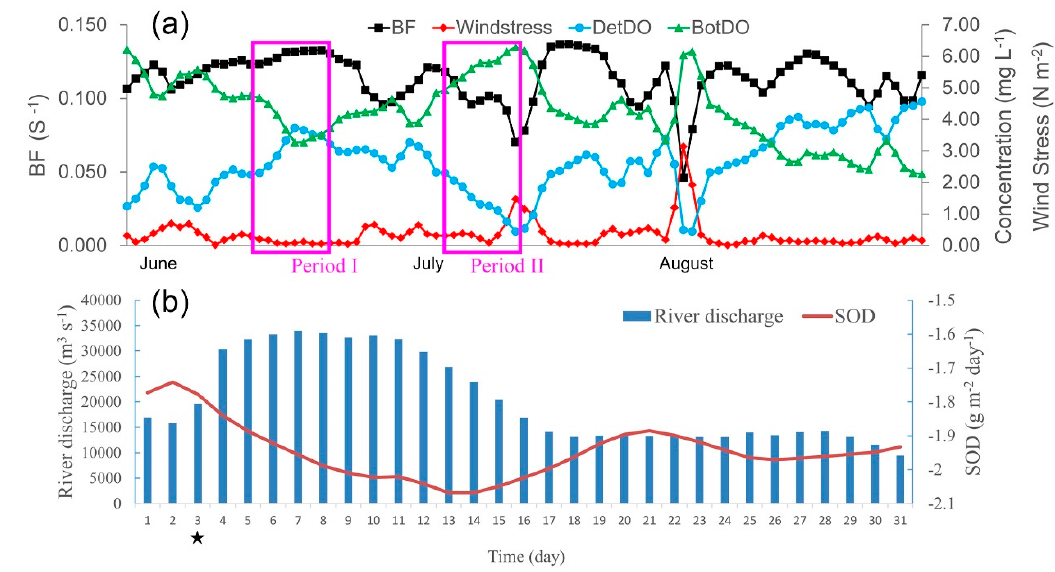
Figure 11. ( a ) Daily average value of the Brunt–Väisälä buoyancy frequency (BF, black line), wind stress (red line), DO concentration differences between the surface layer and bottom layer (DetDO, blue line), and the bottom DO concentration (BotDO, green line) in the Modaomen hypoxic zone of the base case from June to August. The pink windows denote the weak wind (Period I) and strong wind (Period II) periods, respectively. ( b ) Time series of the Pearl River discharge and the SOD in the Modaomen hypoxic zone during August 2006. Note that the SOD is negative representing that it is a sink to bottom water DO. The arrival time of the typhoon on 3 August is denoted by the black star.